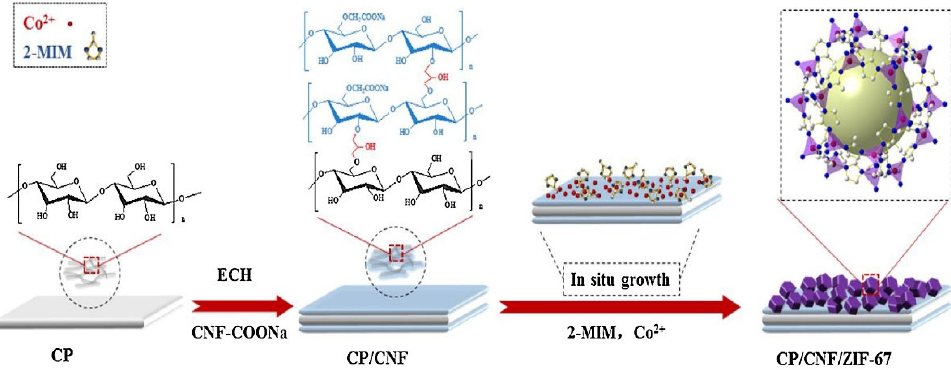
Figure 23. The scheme showing the synthesis of CP/CNF/ZIF ‐ 67 composite. The fabrication process is done by first grafting CNF on the surface of CP via Williamson reaction, then ZIF ‐ 67 is reacted on situ, to yield CP/CNF/ZIF ‐ 67. Reproduced with permission from [182] .